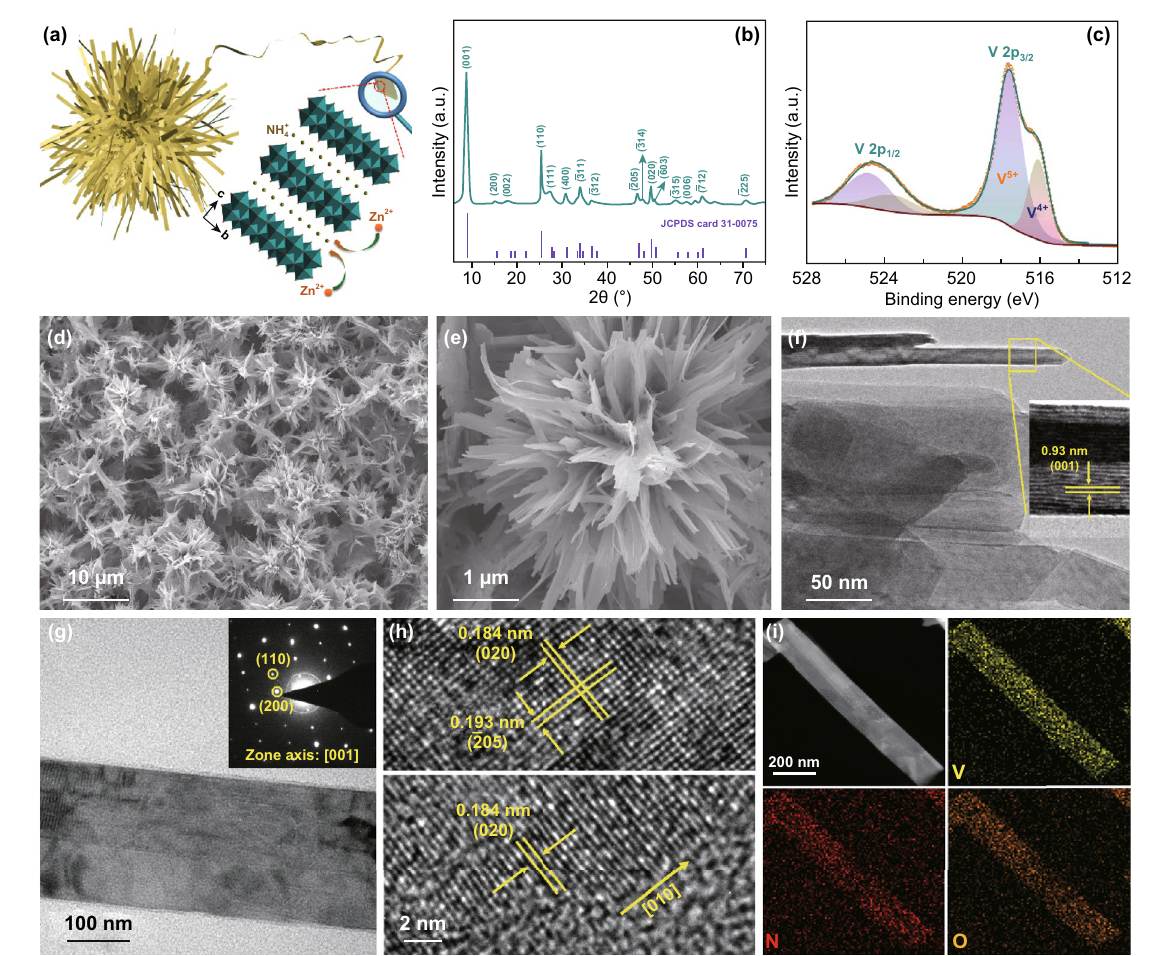
Fig. 2 a Schematic illustration of the designed 3D‑NVO architecture. Chemical and physical characterization of the 3D‑NVO: b XRD pattern, c high‑resolution XPS spectrum of the V 2p region, d , e SEM images, f TEM image (inset: HRTEM image of a lateral‑lying nanobelt), g TEM image of an individual nanobelt (inset: the corresponding SAED pattern), h HRTEM images, and i STEM and the corresponding elemental map‑ ping